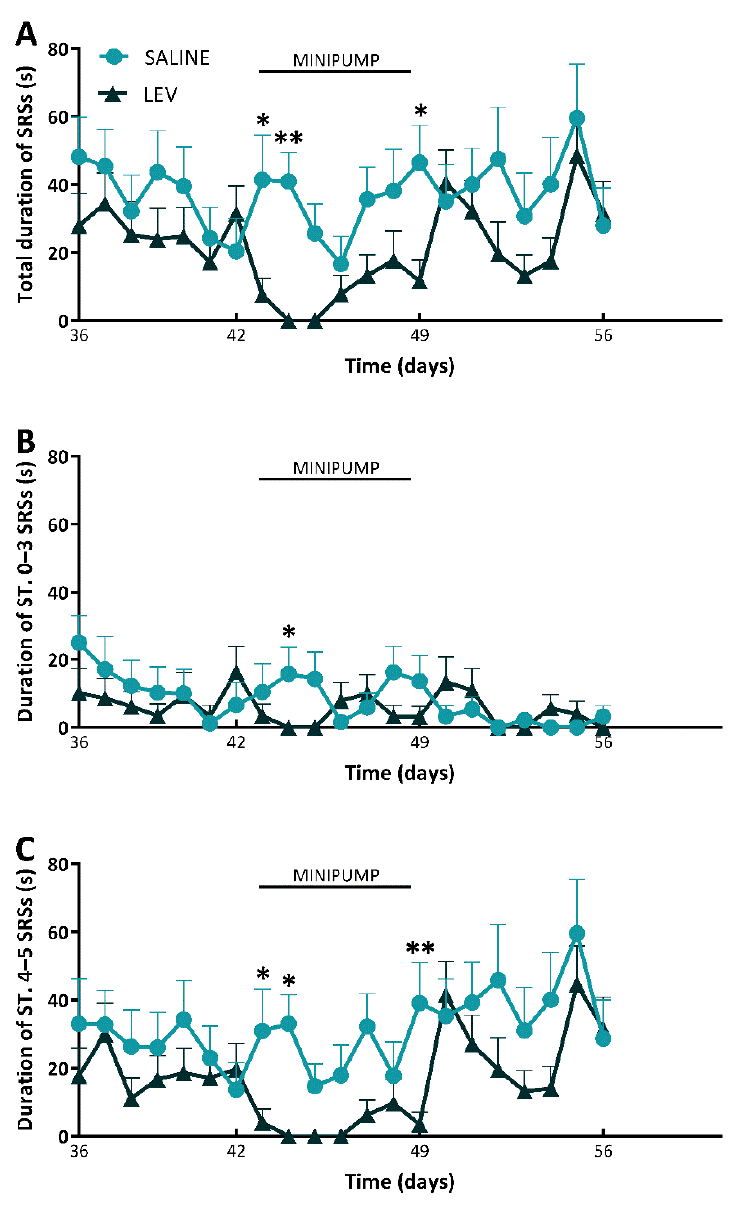
Figure 2. Duration of spontaneous recurrent seizures (SRSs) in epileptic rats treated with levetiracetam (LEV) or saline. All epileptic rats ( n = 30) were treated with LEV ( n = 15) or saline ( n = 15). In ( A ), the treatment with LEV had beneficial effects on total duration of SRSs 1, 2 and 7 days after the implantation of osmotic minipump. Particularly, LEV displayed significant effects on stage 0–3 SRSs ( B ), and generalized stage 4–5 SRSs ( C ). * p < 0.05, ** p < 0.01, Holm-Šidák test; SALINE vs. LEV. ST., stage.